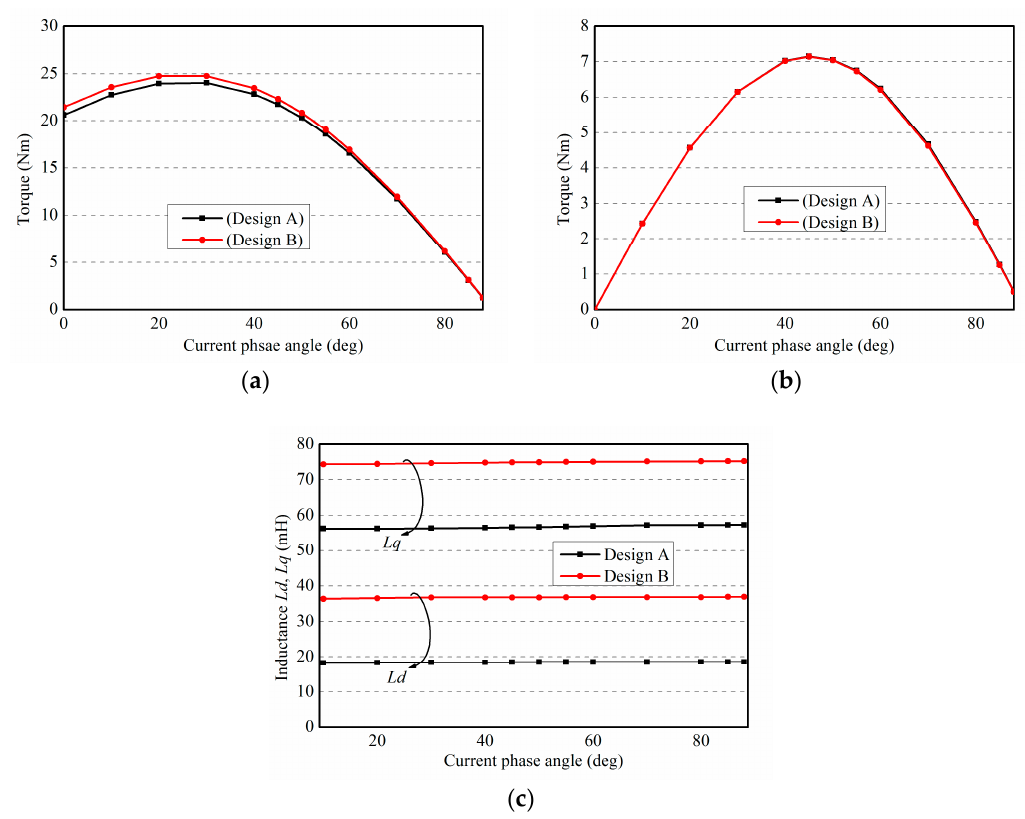
Figure 13. Torque and inductance under different current phase angles with the current magnitude of 5 A: ( a ) Total torque; ( b ) Reluctance torque; ( c ) Inductances.